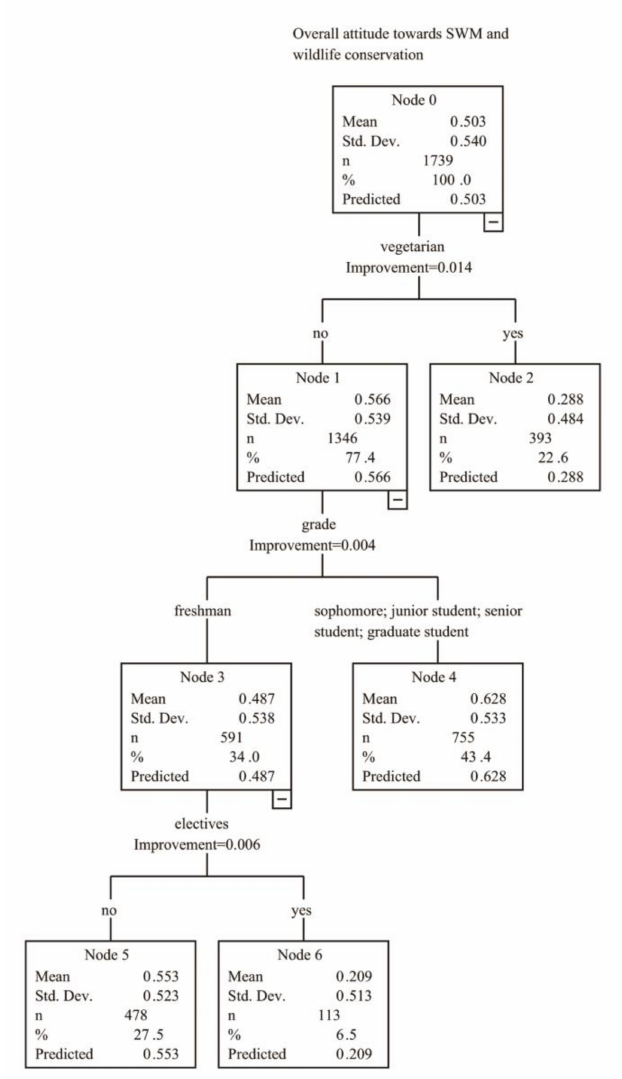
Figure 4. The classification and regression tree (CART) model for overall attitude toward SWM and wildlife